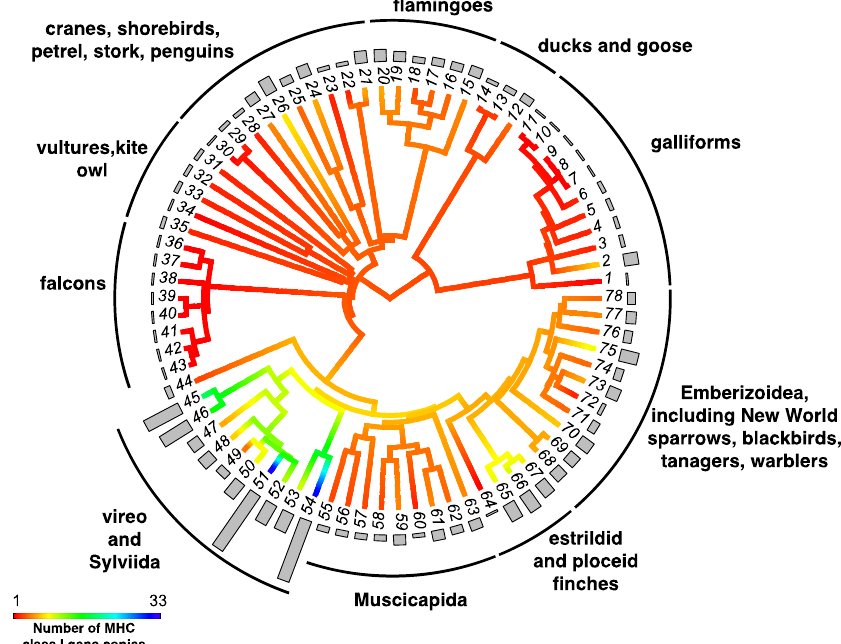
Figure 2. Ancestral character estimation of gene copy number at MHC class I genes along the branches and nodes of a tree for birds. Bars associated with each terminal node indicate the estimated number of MHC gene copies. Figure modified from Minias et al. 2018 [103]. Key to species names is supplied in Supplementary Table S1.